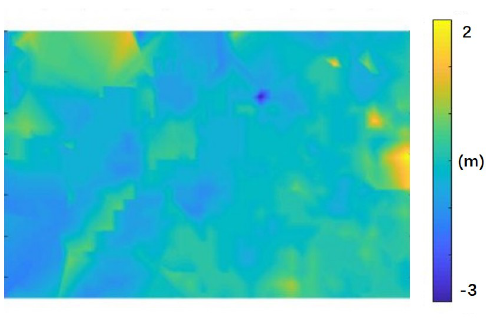
Figure 16. Final DEM generated by the presented method.